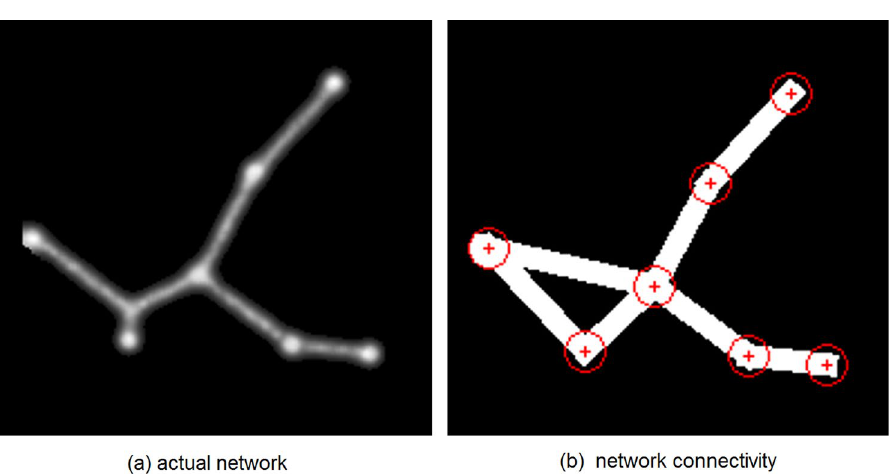
Figure 10. Analysis of model network method. ( a ) Fragment of model network showing trails (grey), nodes (white) and additional Steiner node, ( b ) analysed network where indirect connections via the Steiner node are interpreted as connecting the indirectly linked regions (edges as white bars, nodes circled) (Simulation result and connectivity graph from custom Java simulation of slime mould (https://www.processing.org/) by author